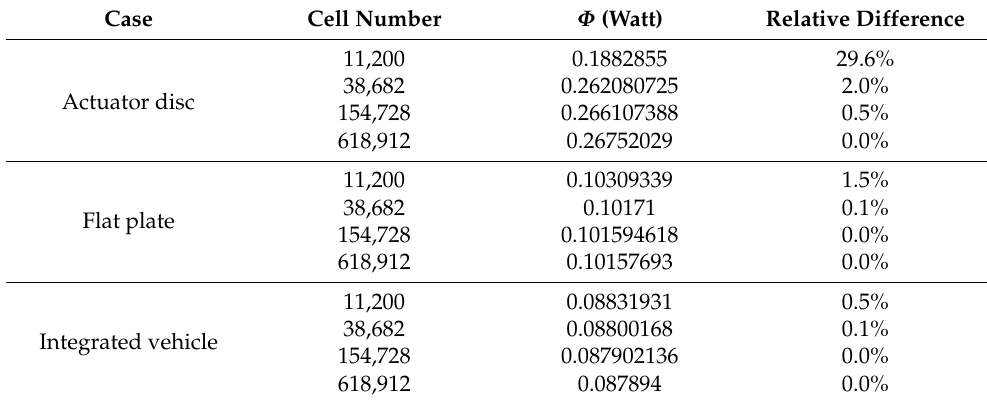
Figure 6. A common computational domain for an actuator disc, a flat plate, and an integrated vehicle model [19]. Table 3. Mesh sensitive study for laminar